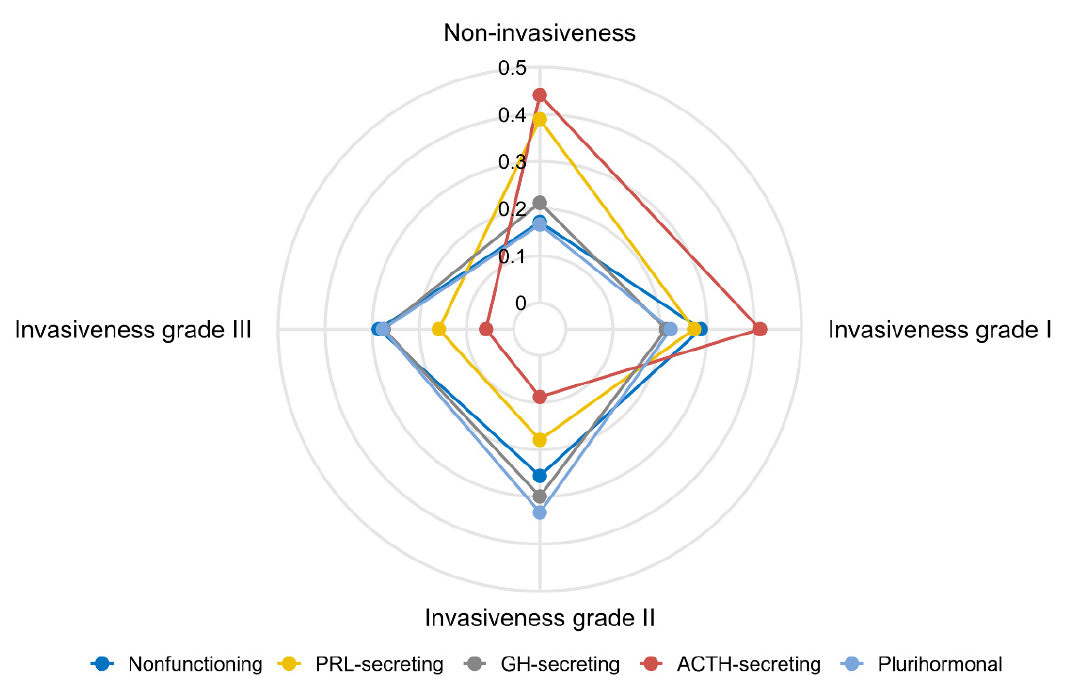
Figure 3. Radar chart illustrating the proportional distribution of invasiveness for different clinical subtypes. PRL: Prolactin; GH: Growth Hormone; ACTH: Adrenocorticotropic Hormone.